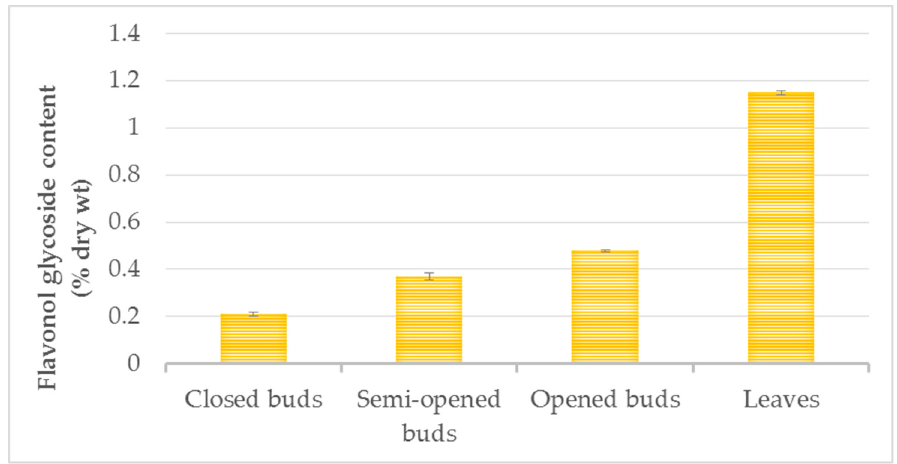
Figure 5. Flavonol content (% dry wt) of three physiological states of ginkgo buds and summer leaves. Data are given as mean ± SD, replicates are n = 3 and p < 0.001.